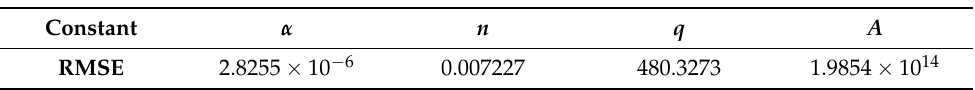
Table 2. Errors of the material constants calculated by the polynomial functions. RMSE: root mean square